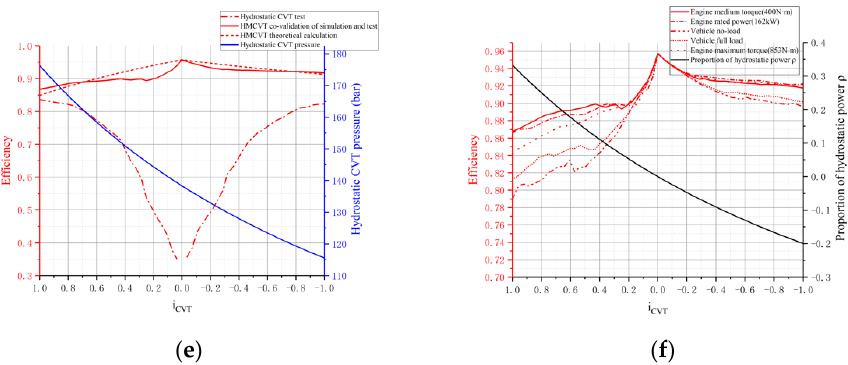
Figure 20. HMCVT efficiency under different working conditions: ( a ) Vehicle full load; ( b ) Vehicle Figure 20. HMCVT e ffi ciency under di ff erent working conditions: ( a ) Vehicle full load; ( b ) Vehicle no-load; ( c ) Engine rated power (162kW); ( d ) Engine maximum torque (853N·m); ( e ) Engine medium no-load; ( c ) Engine rated power (162 kW); ( d ) Engine maximum torque (853 N · m); ( e ) Engine medium torque (400N·m); ( f ) Comprehensive comparison of efficiency. torque (400 N · m); ( f ) Comprehensive comparison of e ffi